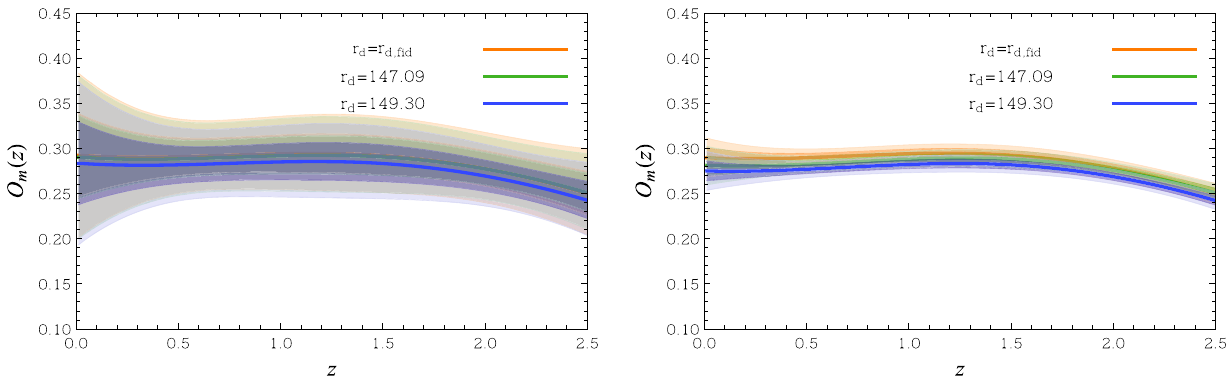
Fig. 8 O m ( z ) vs z with 1 σ and 2 σ CL regions, reconstructed from SN+CC (green) and SN+CC+BAO (blue) in the left panel, and SN+CC+H0LiCOW (green) and SN+CC+H0LiCOW+BAO (blue) in the right panel